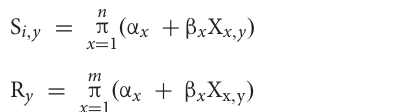
Mature adults: pre-spawning